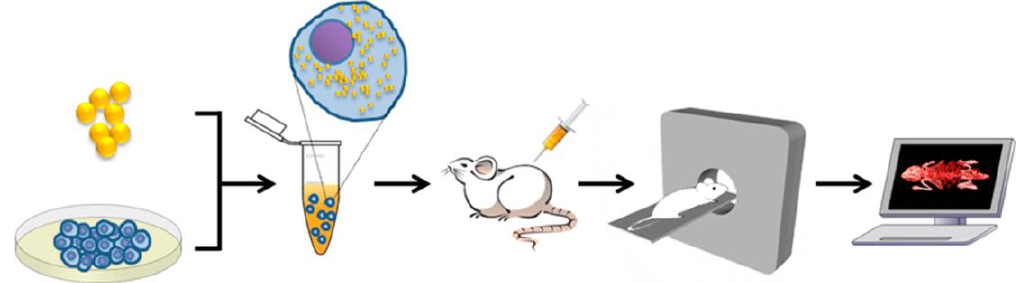
Figure6. Cellulartracking usinggoldnanoparticles asa contrastagentand imagedwith CT.Reproduced Figure 6. Cellular tracking using gold nanoparticles as a contrast agent and imaged with CT. with permission from Ref. Reproduced with permission from Ref. [77].